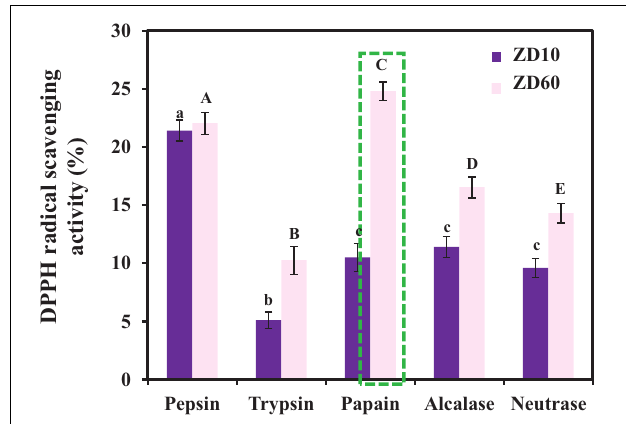
FIGURE 2 | DPPH · scavenging activities of different enzymatic hydrolysates of ZD10 [proteins precipitated using 10% (NH 4 ) 2 SO 4 ] and ZD60 [proteins precipitated using 60% (NH 4 ) 2 SO 4 ] at the concentration of 10 mg/ml. All data were presented as the mean ± SD ( n = 3). a - c or A - E Values with the different letters indicate a significant difference ( p <